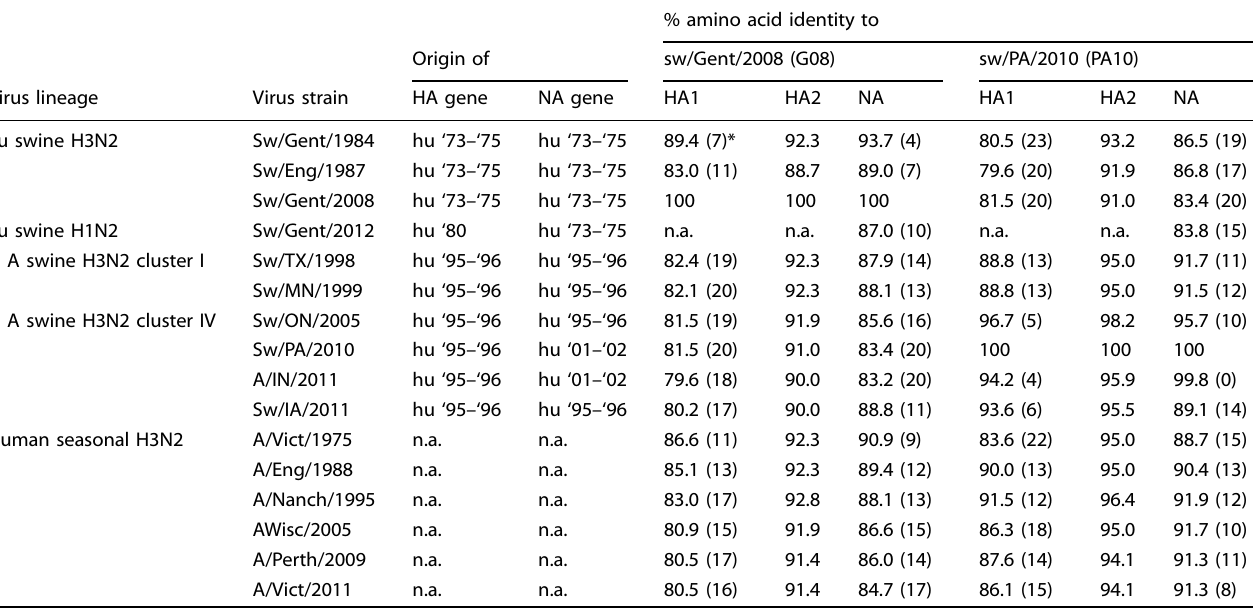
Table 1. In fl uenza virus strains used in serological assays and their genetic relationship with the HA and NA of both vaccine strains % amino acid identity